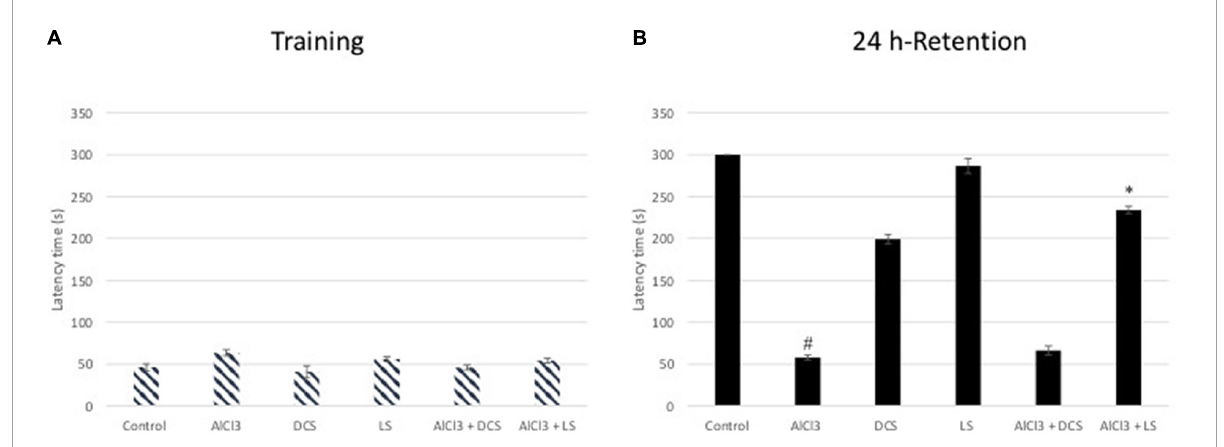
FIGURE3 Performance in the passive avoidance test. The training latencies (A) and the retention latencies (B) to enter the dark chamber during sessions are shown. All values are expressed as the mean ± standard deviation. Significance difference between groups indicated by: # between control and AlCl 3 , * between AlCl 3 and treatment